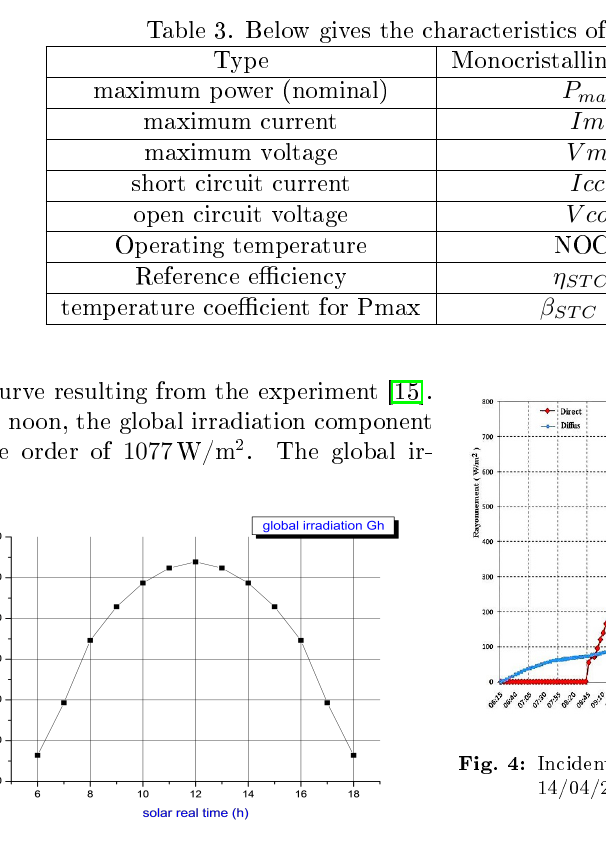
Fig. 3: Temporal evolution of the daily global irradia- tion for n = 228 and with a pure sky. radiation component represents the sum of the two components of radiation, the direct and the di(cid:27)use. The two (cid:28)gures below clearly show the validation of Kasten’s model. Figure 4 shows the temporal evolution of the two components,